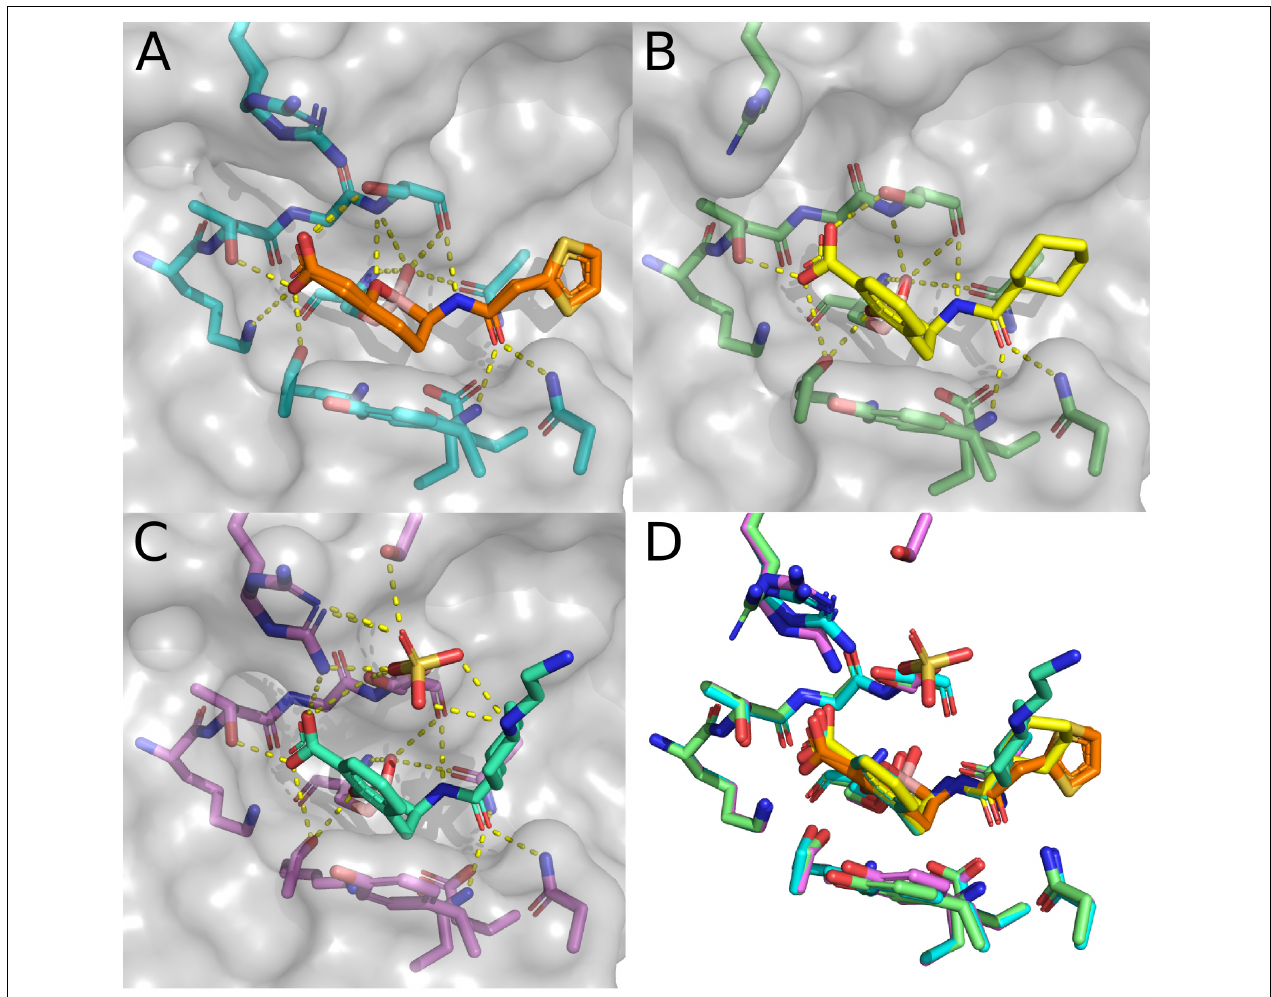
FIGURE 6 | Structures in complex with BATSIs. (A) Structure of CTX-M-15 in complex with vaborbactam (4XUZ). (B) Structure of CTX-M-15 in complex with 1C (5T66). (C) Structure of CTX-M-15 in complex with taniborbactam (6SP6). (D) Overlay of the active sites for CTX-M-15 in complex with vaborbactam, 1C, and